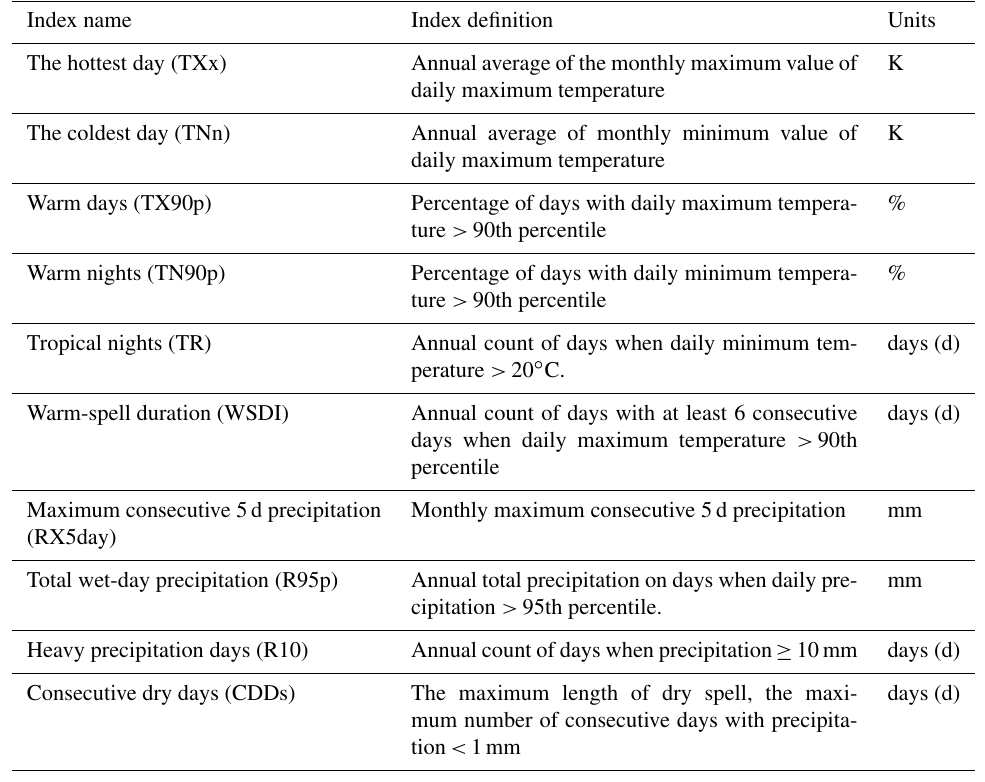
Table 2. Definitions of the extreme climate indices used in this study.